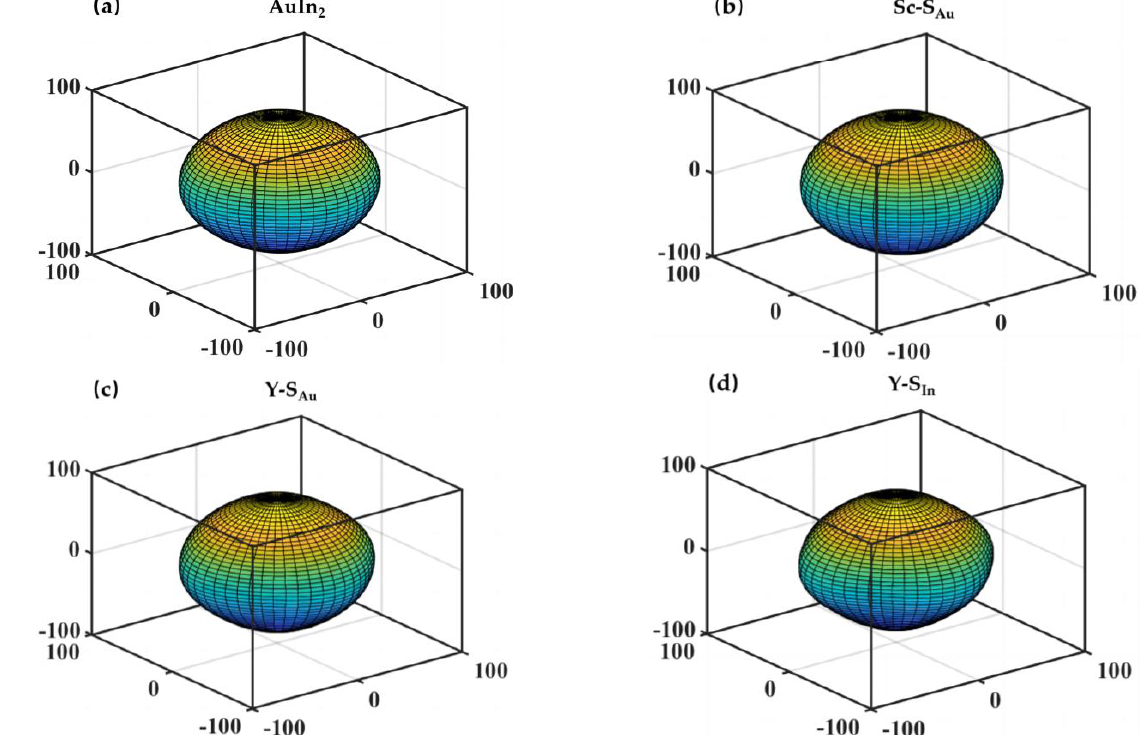
Figure 4. Three − dimensional surface structures of bulk modulus of AuIn 2 and RE doped systems. For all the graphs, the units are GPa. ( a ) AuIn2 ( b ) Sc-SAu ( c ) Y-SAu ( d ) Y-SIn.